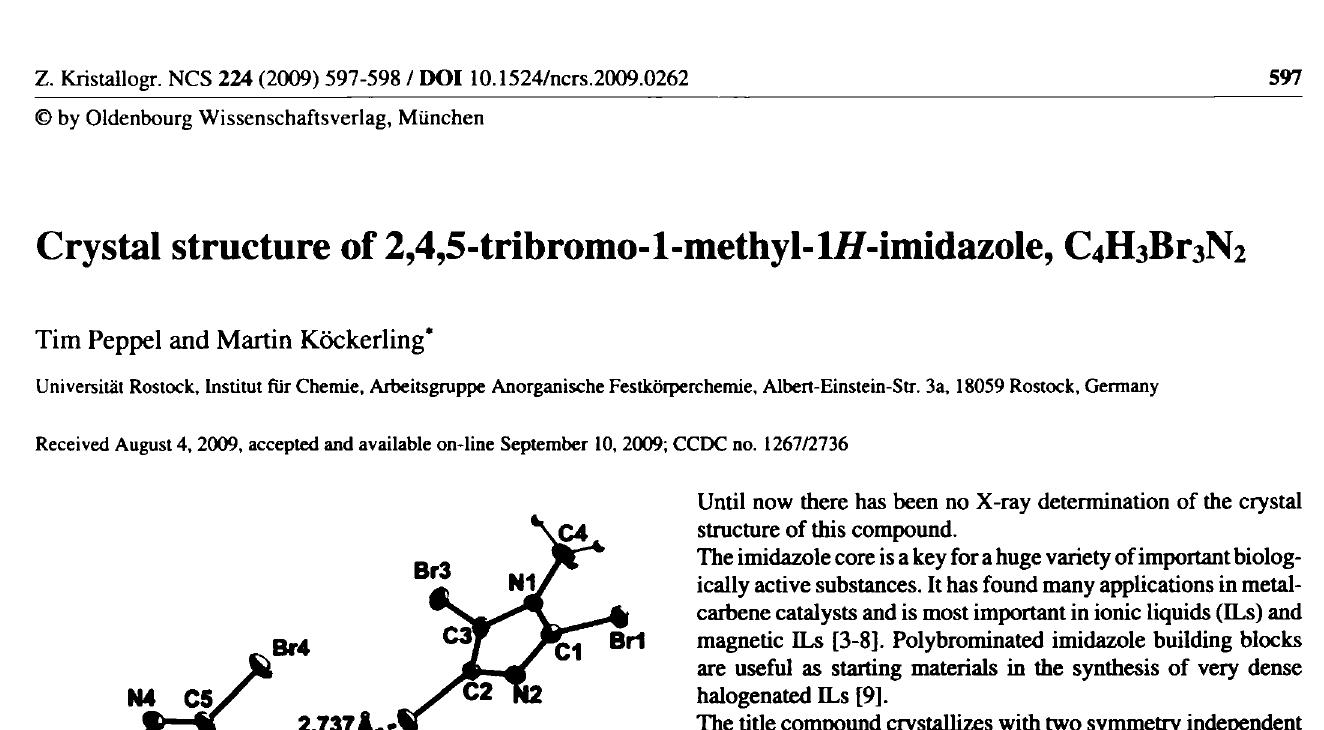
Table 1. Data collection and handling.